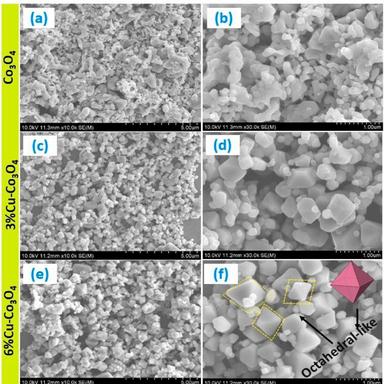
FESEM images of Co3O4 (a,b), 3%Cu–Co3O4 (c,d), and 6%Cu–Co3O4 (e,f).